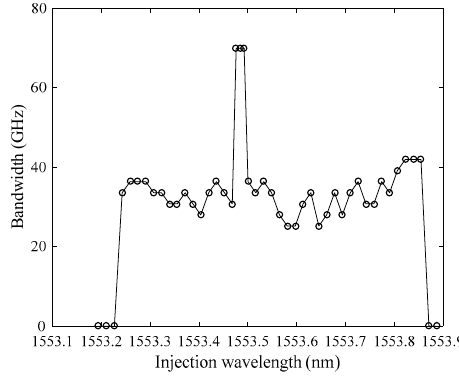
Figure 9. Evolution of the total-OFC bandwidth as a function of the injection light wavelength for the gain-switching VCSEL at injection power P i = 266.80 μ W.